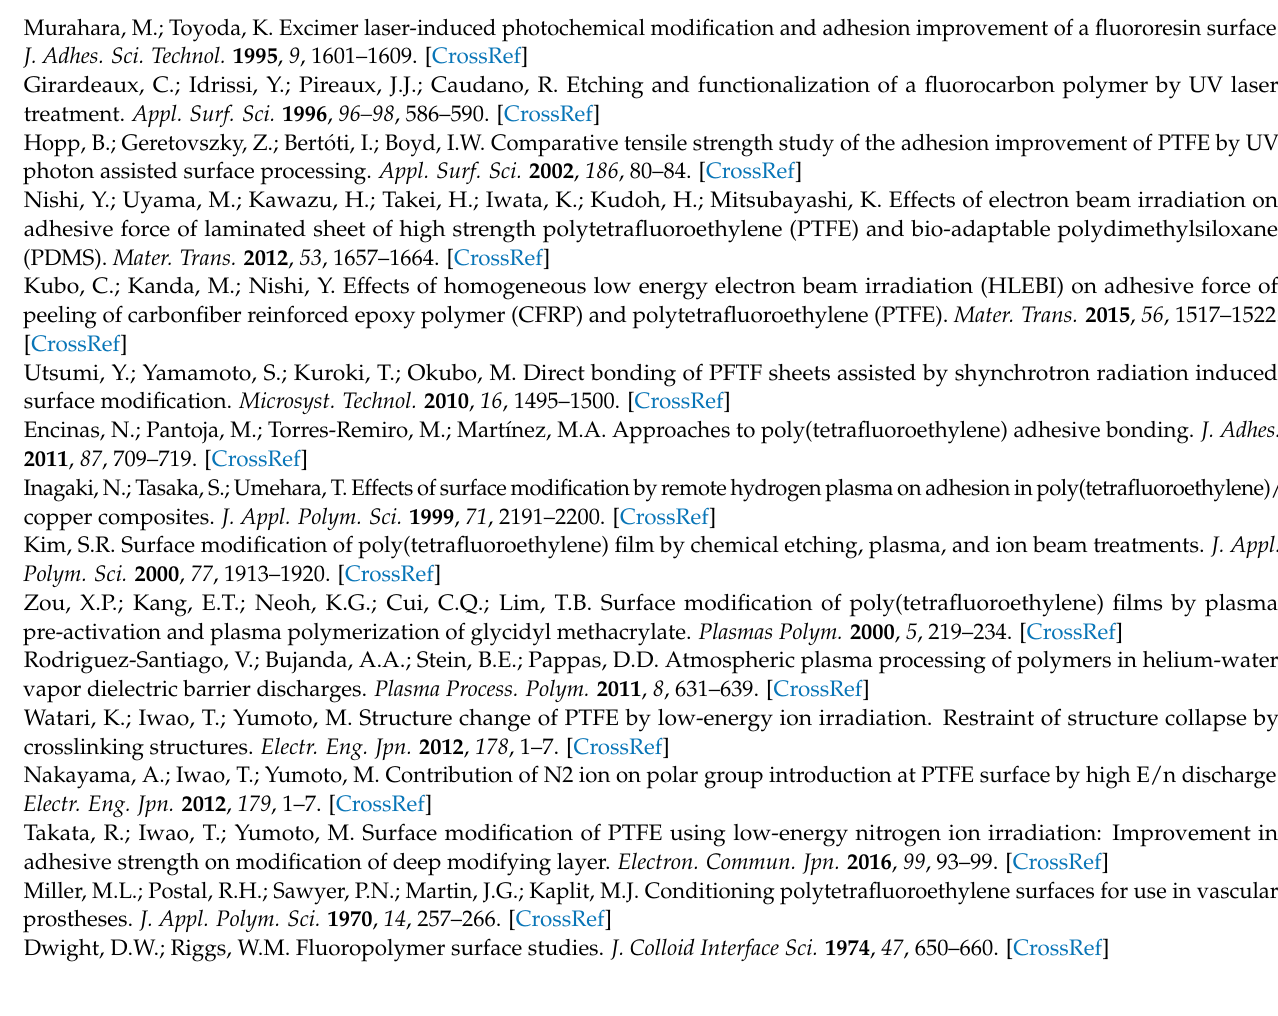
(c) He plasma-treated PTFE with an MgF 2 substrate, and (d) Ar plasma-treated PTFE with an MgF 2 substrate. Figure S3: O1s-XPS spectra of the PTFE samples HAP-treated using He or Ar gas. (a) As-received PTFE, (b) He-HAP-treated PTFE, and (c) Ar-HAP-treated PTFE. Figure S4. Gas cluster ion beam (GCIB) sputtering depth observed using a scanning white-light interferometer (SWLI). (a) SWLI image of the front view and (b) cross-sectional view around the GCIB sputtering hall. Figure S5. Surface hardness histograms of the PTFE samples plasma-treated using He or Ar gas with heating. (a) As-received PTFE, (b) He heat-assisted-plasma (HAP)-treated PTFE, and (c) Ar-HAP-treated